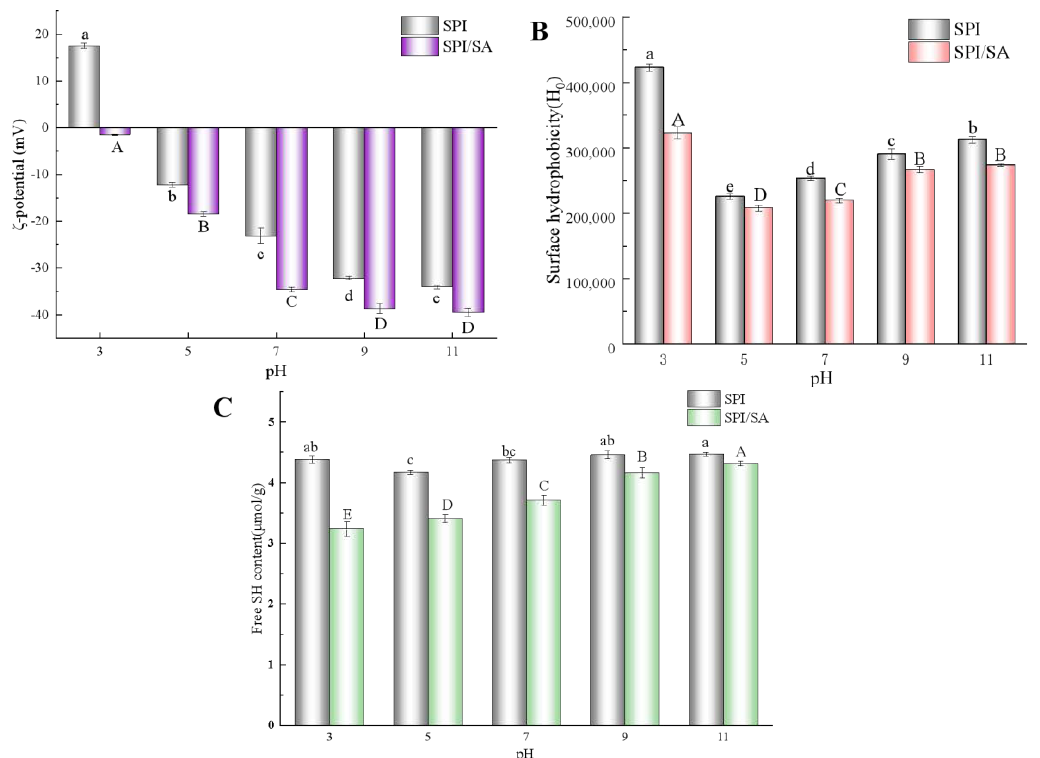
Figure 1. The ζ -potential ( A ), surface hydrophobicity ( H 0 ) ( B ), and free SH content ( C ) of SPI and SPI/SA microparticles at different pH values. Different lowercase letters (a–e) within a column for each SPI microparticles are significantly different ( p < 0.05). Different capital letters (A–E) within a column for each SPI/SA microparticles are significantly different ( p <